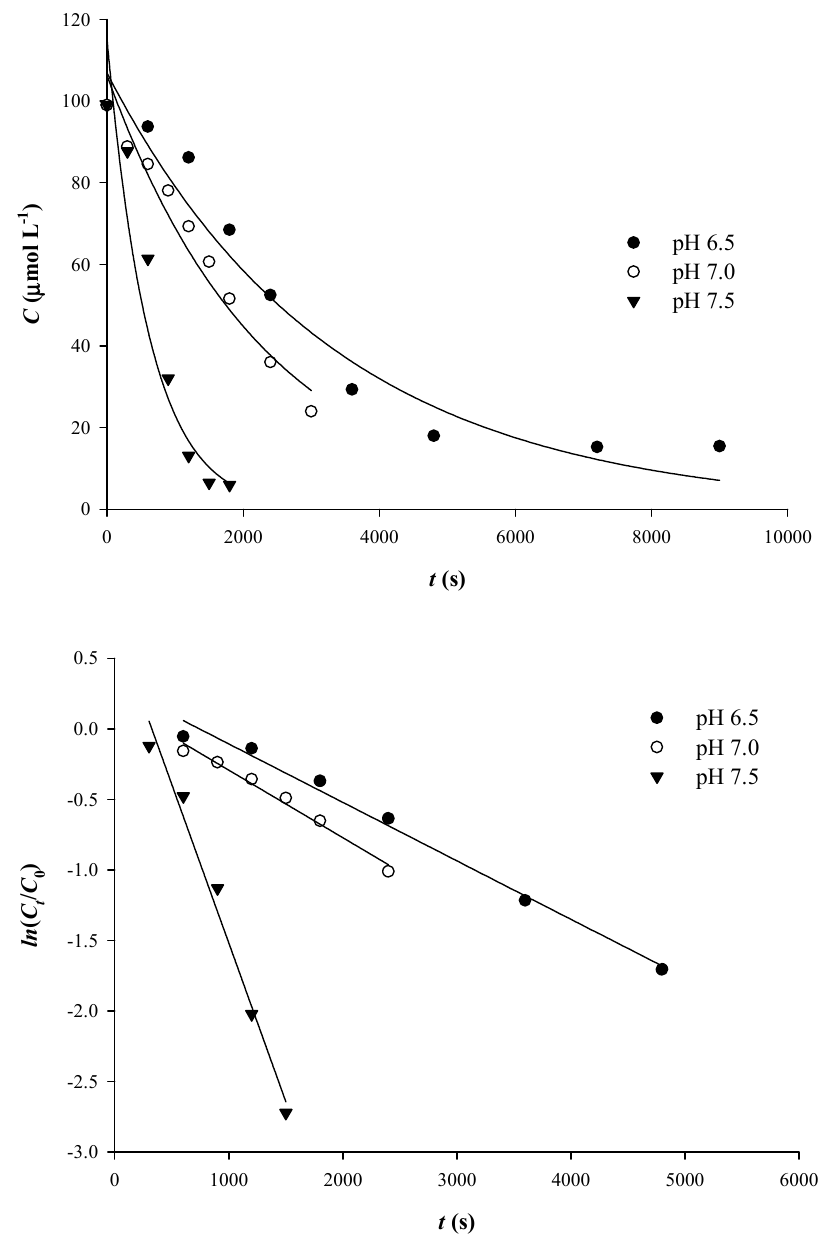
Figure 1. Kinetics of Qt thermal degradation (100 µ mol L − 1 ) at pH 7.5 and 90 ◦ C ( upper plot ). Verification of the first-order kinetics are shown by a linear plot ( lower plot ).